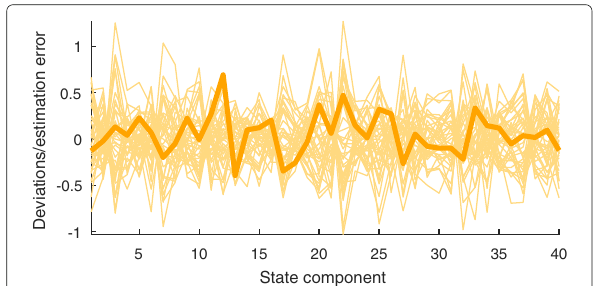
Fig. 18 The estimation error x k − ¯ x k | k for k = 10 4 with the deviation ensemble (cid:7) X k | k in the background for an EnKF with N = 40, covariance localization, and inflation factor c =